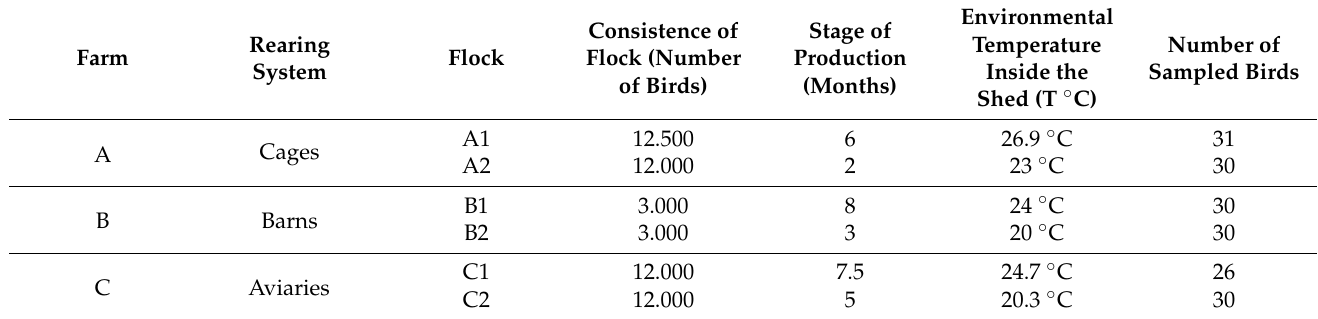
Table 1. Rearing systems and details about flocks and tested